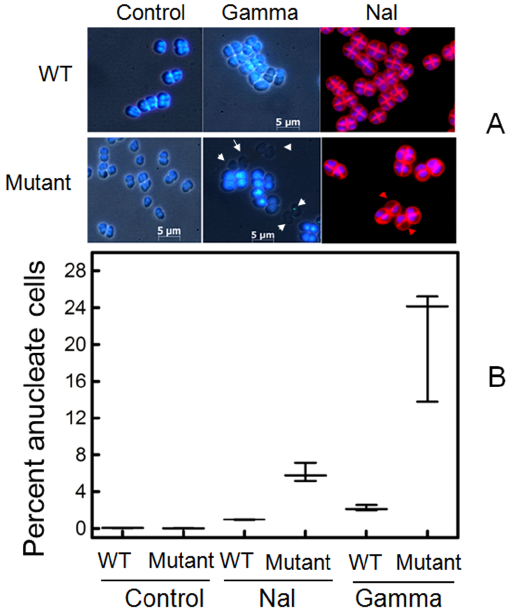
Figure 3. PprA promotes D.radiodurans genome maintenance following DNA damage. Both wild type (WT) and pprA mutant (Mutant) D. radiodurans cells were treated with nalidixic acid (Nal) for 2 h and 6 kGy c radiation (gamma) and stained with DAPI to detect anucleate cells. Representative micrographs are shown in (A), where anucleate cells, lacking DAPI fluorescence, are indicated with arrows. The percent anucleate cells in each condition ( , 500 cells/sample) is plotted in (B).